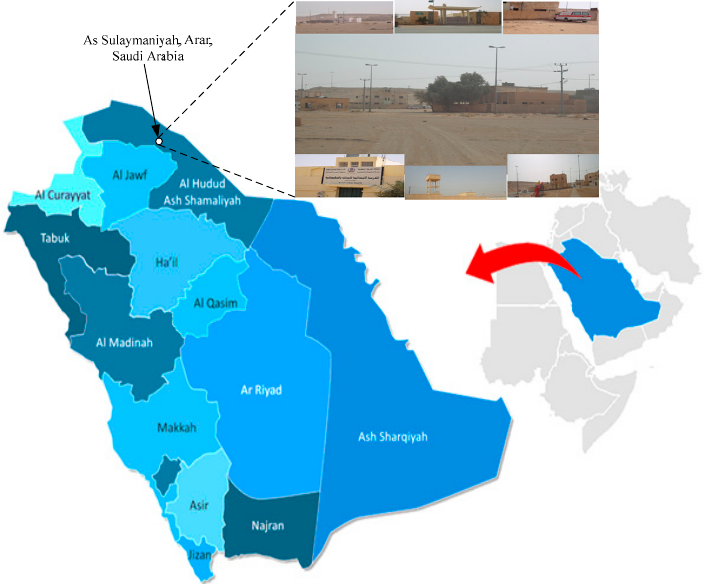
Figure 1. Geographical location of the selected village in Arar, Saudi Arabia.